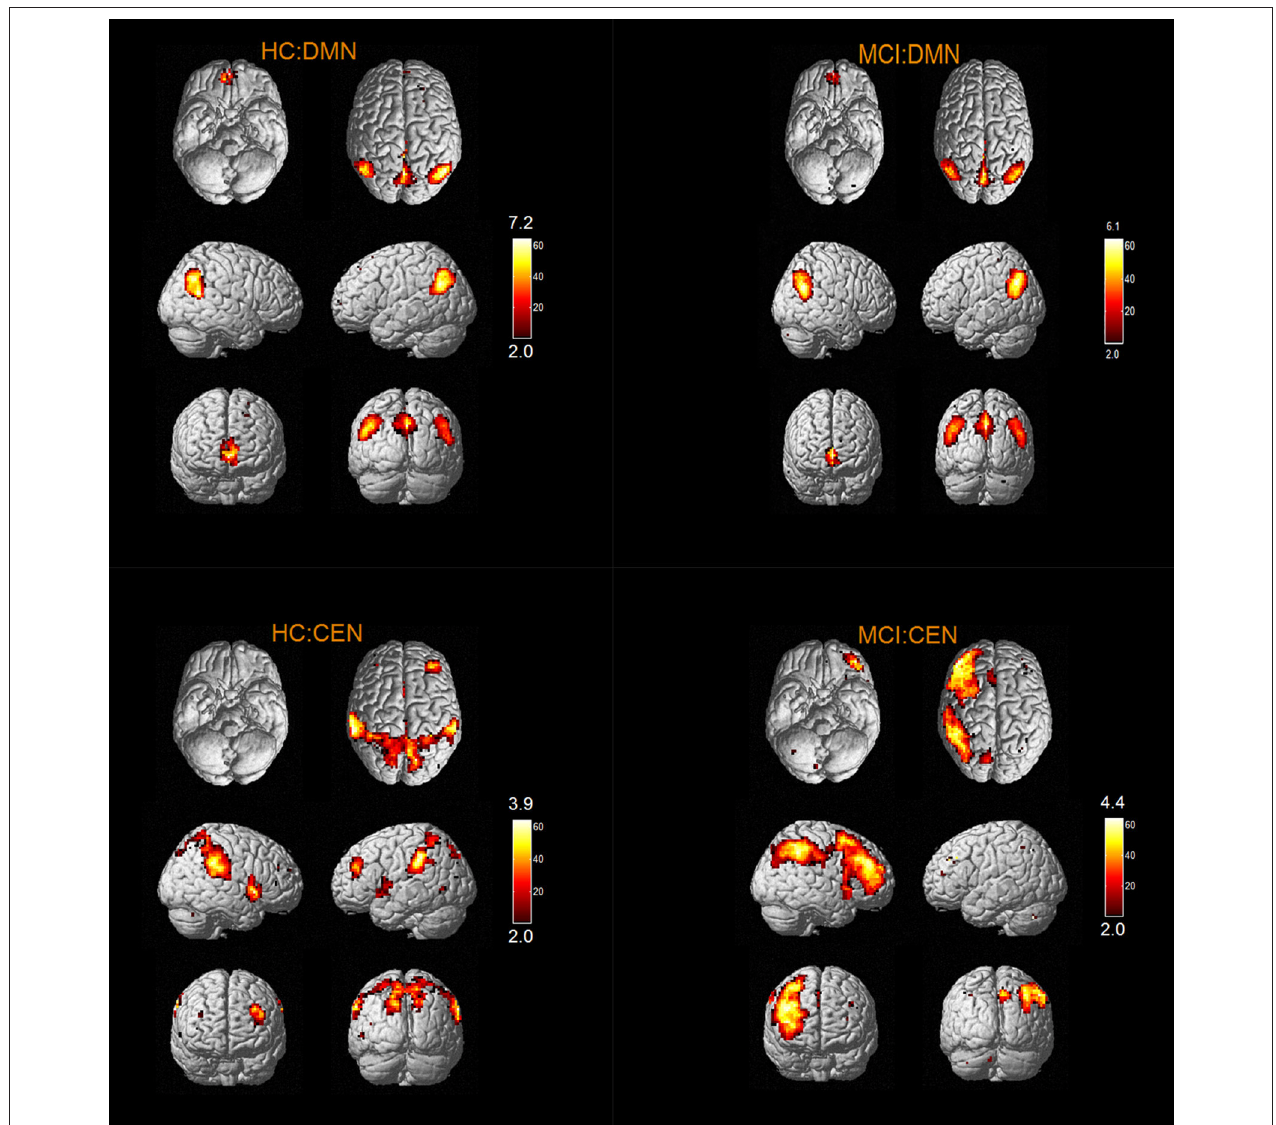
FIGURE 1 | The spatial distribution of DMN, CEN, SMN in MCI group and HC group.